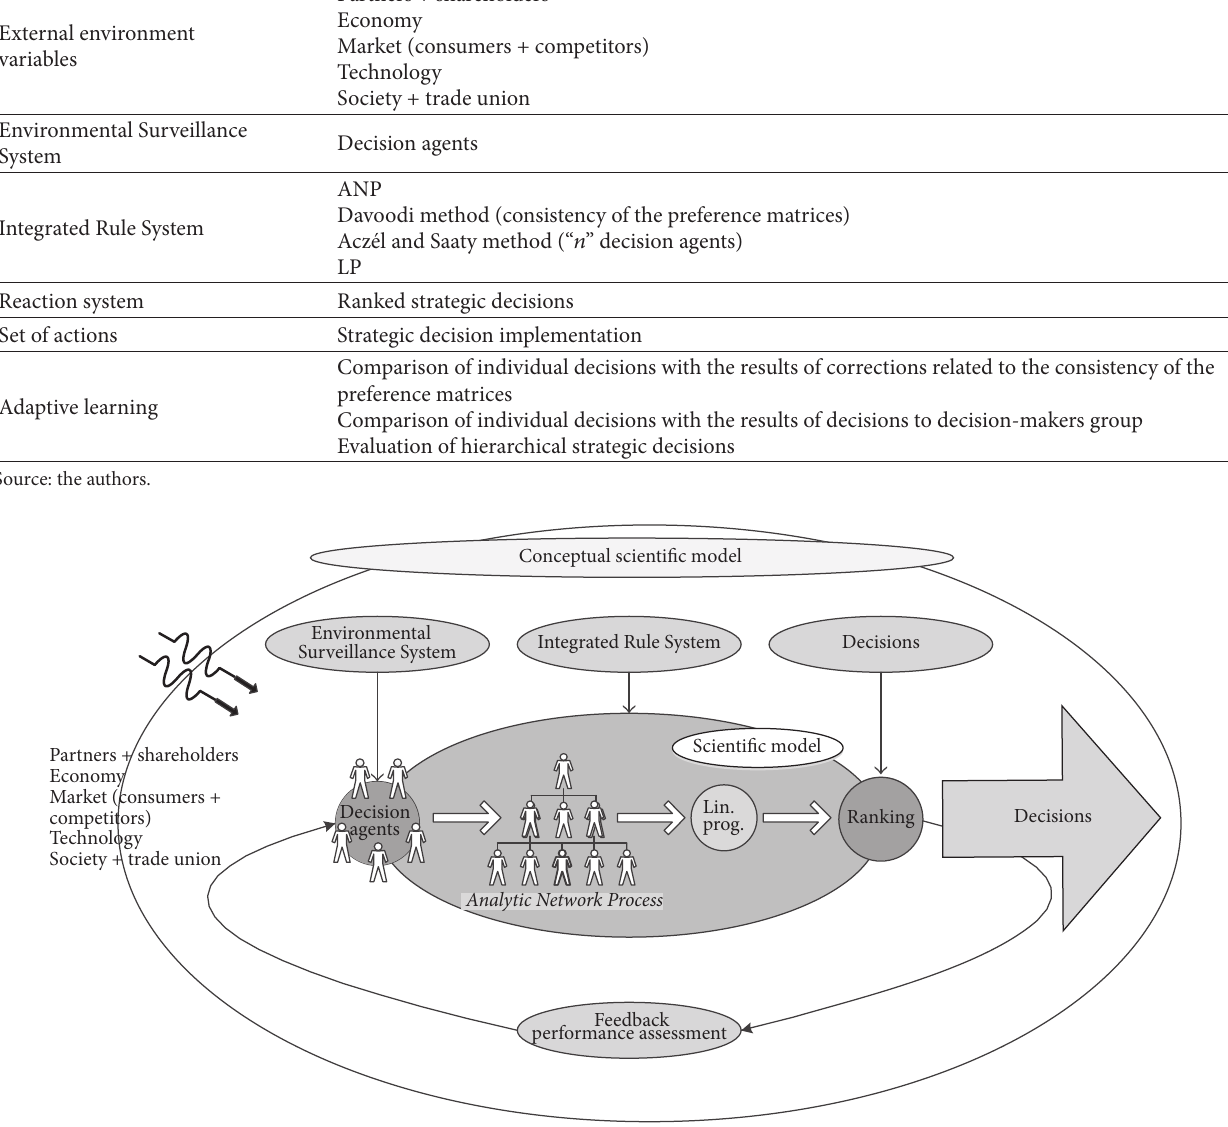
Figure 3: Conceptual scientific model. Source: the